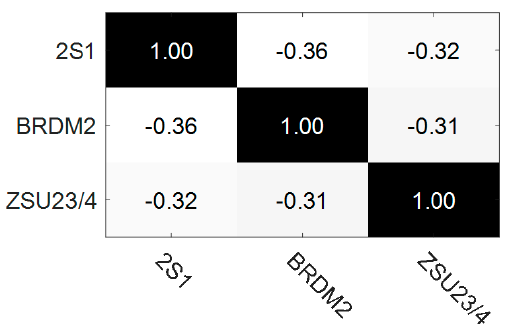
Figure 12. Correlation coefficients of three different tasks. The term’2S1’means the task to recognize vehicle 2S1 and the meanings of other terms are similar to this one.